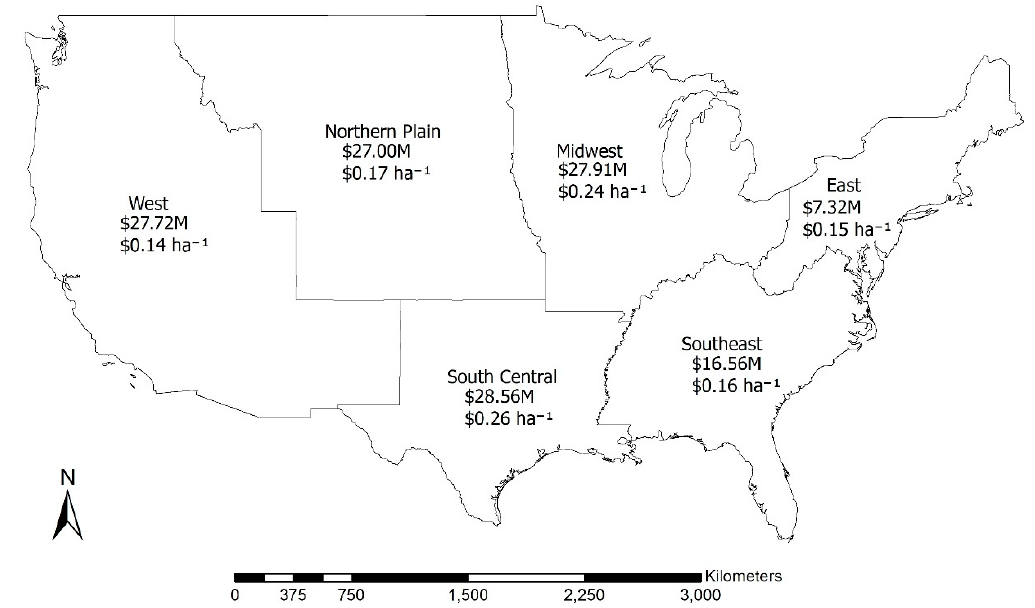
Figure 5. Average annual total ( top number ) and area-normalized ( bottom number ) monetary values of non-constrained potential soil inorganic carbon (SIC) sequestration from combined atmospheric Ca 2 + and Mg 2 + deposition (2000–2015) for di ff erent regions in the contiguous United States (U.S.) based on an avoided SC-CO 2 of $42 per metric ton of CO 2 [16]. Note: M = million = 10 6 .